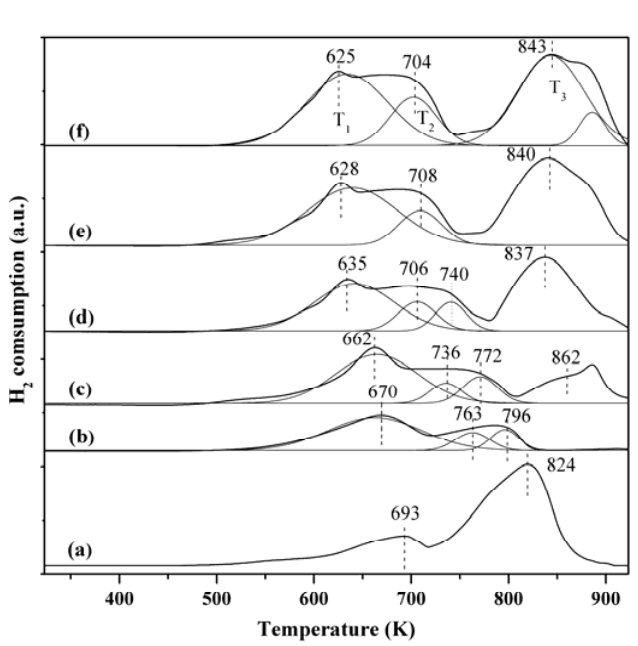
Figure 7. H 2 ‐ TPR profiles of the catalysts Mn ‐ Co/TiO 2 (773 K) with various Co contents: ( a ) 5Co/TiO 2 ; Figure 7. H 2 -TPR profiles of the catalysts Mn-Co/TiO 2 (773 K) with various Co contents: ( b ) 10Mn/TiO 2 ; ( c ) 10Mn ‐ 2Co/TiO 2 ; ( d ) 10Mn ‐ 5Co/TiO 2 ; ( e ) 10Mn ‐ 8Co/TiO 2 ; and ( f ) 10Mn ‐ 10Co/TiO 2 . ( a ) 5Co/TiO 2 ; ( b ) 10Mn/TiO 2 ; ( c ) 10Mn-2Co/TiO 2 ; ( d ) 10Mn-5Co/TiO 2 ; ( e ) 10Mn-8Co/TiO 2 ; and ( f ) 10Mn-10Co/TiO 2